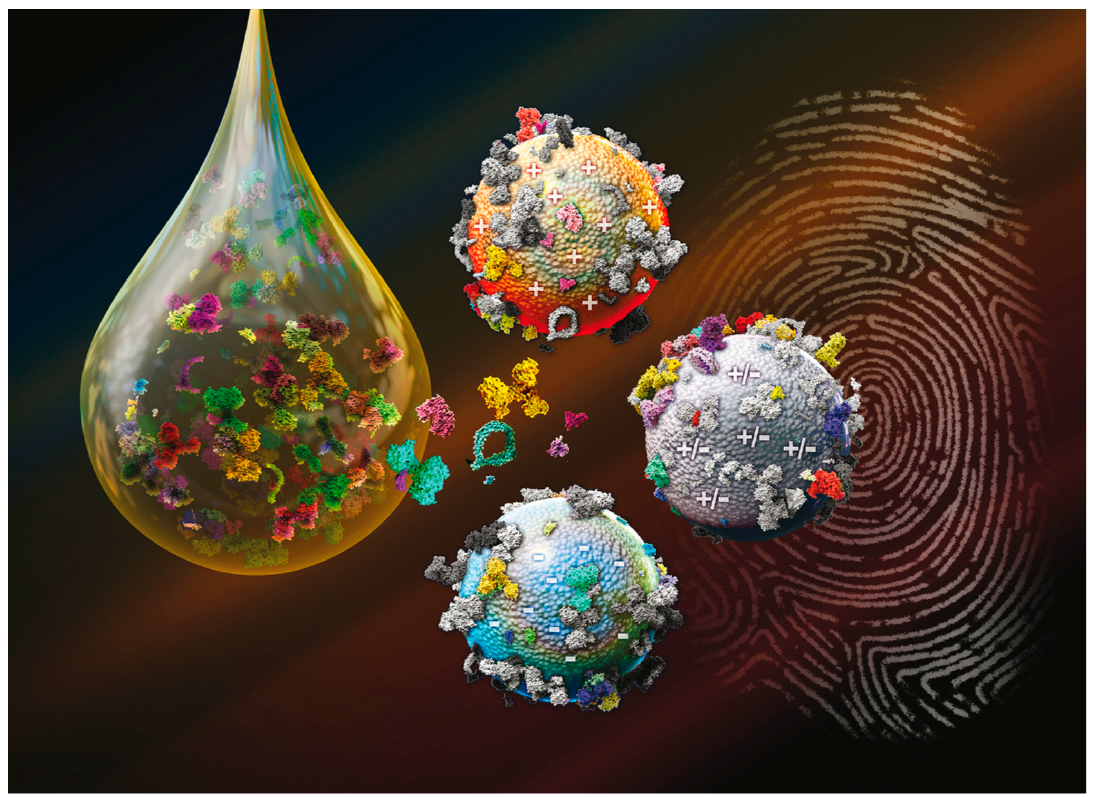
Figure 1. Upon exposure to human plasma proteins, nanoparticles (NPs) are coated by a personalized protein corona. Using a cross-reactive sensor array made of three liposomal formulations, fingerprints for five different cancer types were identified. Adapted from Caracciolo et al. [30] .